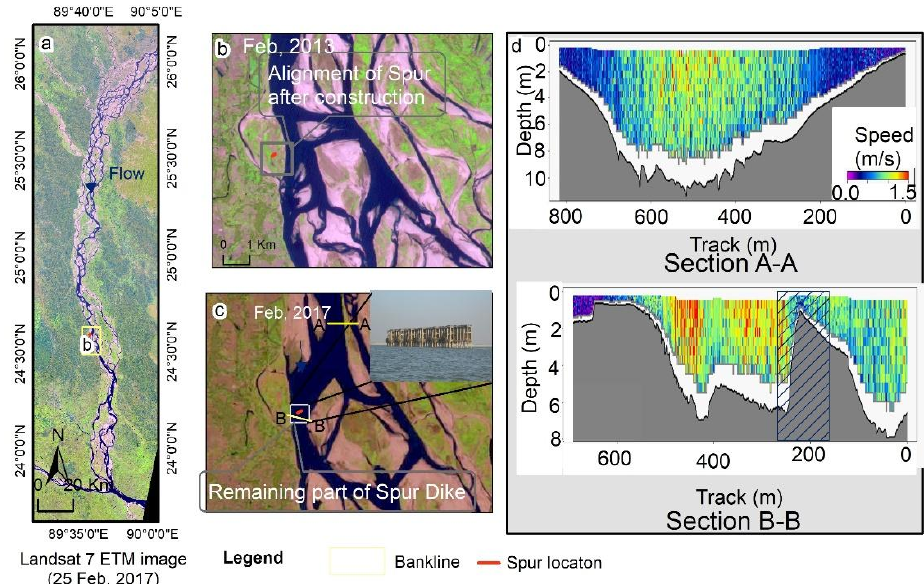
Figure 1. Permeable spur dike in Bangladesh. The shaded area indicates the location perpendicular to the structure.( a ) a failed semipermeable spur dike in the Brahmaputra–Jamuna River. ( b ) initial spur constructed. ( c ) reinforced cement concrete (RCC) part of the dike. ( d ) acoustic Doppler current profiler